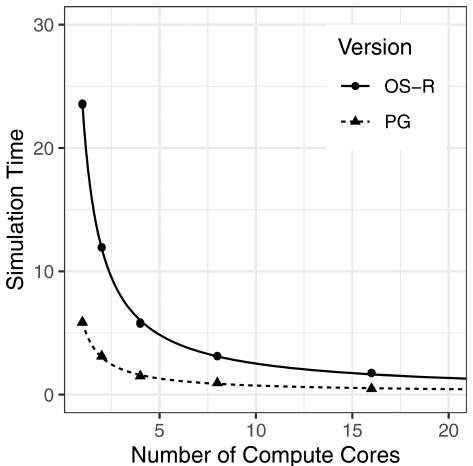
Figure 5. Simulation time (minutes) for 512 grid points simulated with the Decision Support System for Agrotechnology Transfer Cropping System Model (DSSAT-CSM) using R code and text-file- based input–output (OS-R) as well as the parallel gridded version (PG), which uses Network Common Data Form (NetCDF) files, for varying numbers of compute